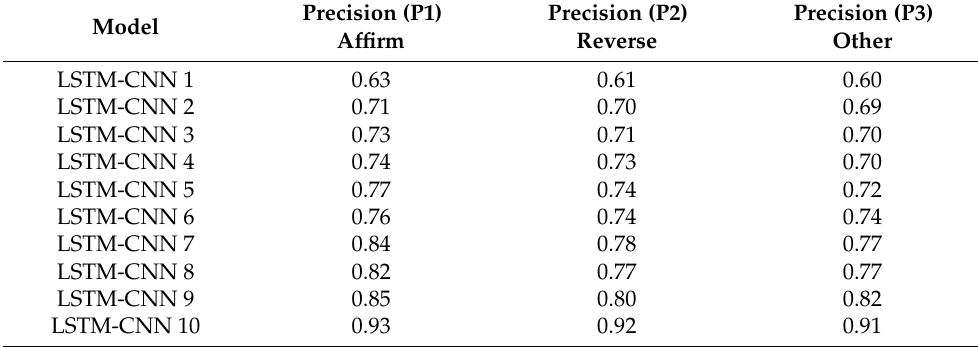
Table 4. LSTM-CNN deep learning models’ precision.